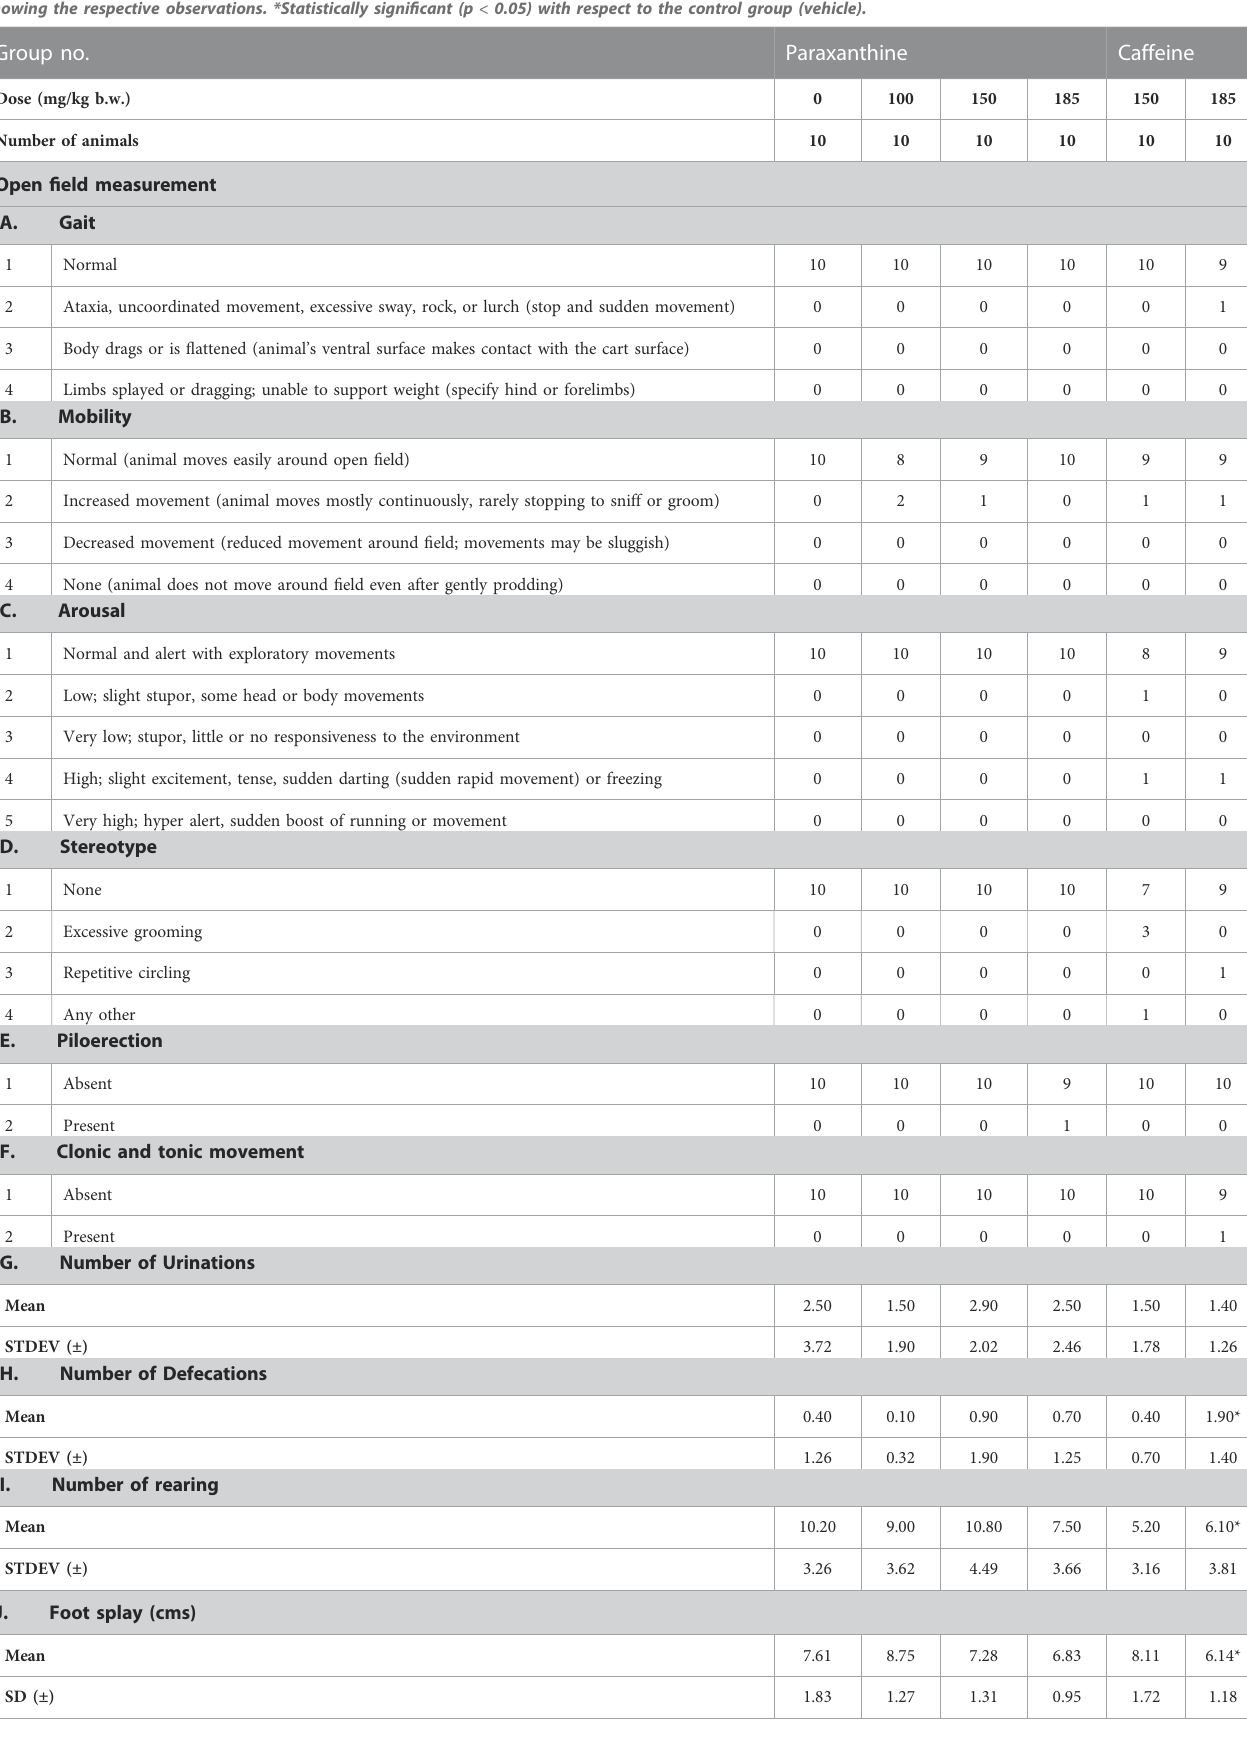
TABLE2Summaryoffunctionalobservationbatterytestmeasurementsinmalesintherepeat-dose90-daytoxicitystudy. Thenumbersrepresentthenumberofanimals showing the respective observations. *Statistically signi fi cant (p < 0.05) with respect to the control group (vehicle). Group